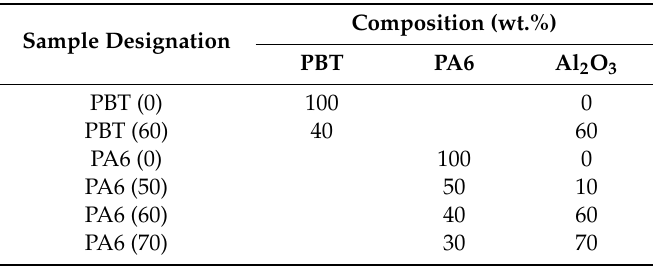
Table 1. Content of PBT, PA6, and Al 2 O 3 used for the preparation of polymer